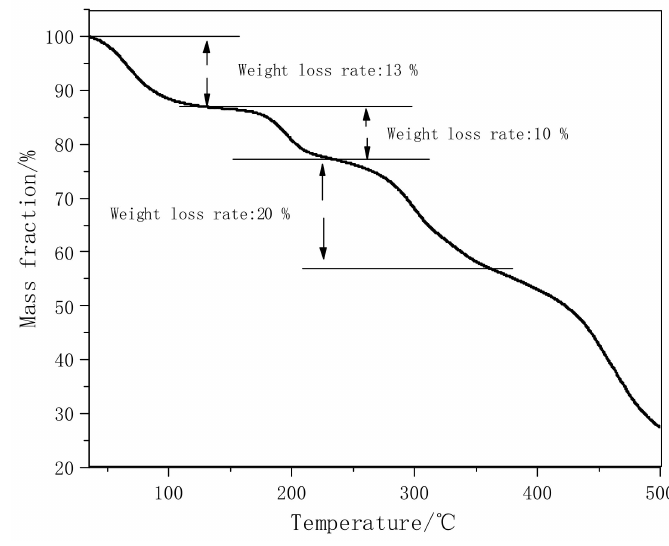
Figure 3. TG curve of PVA-AA-t under N 2 .